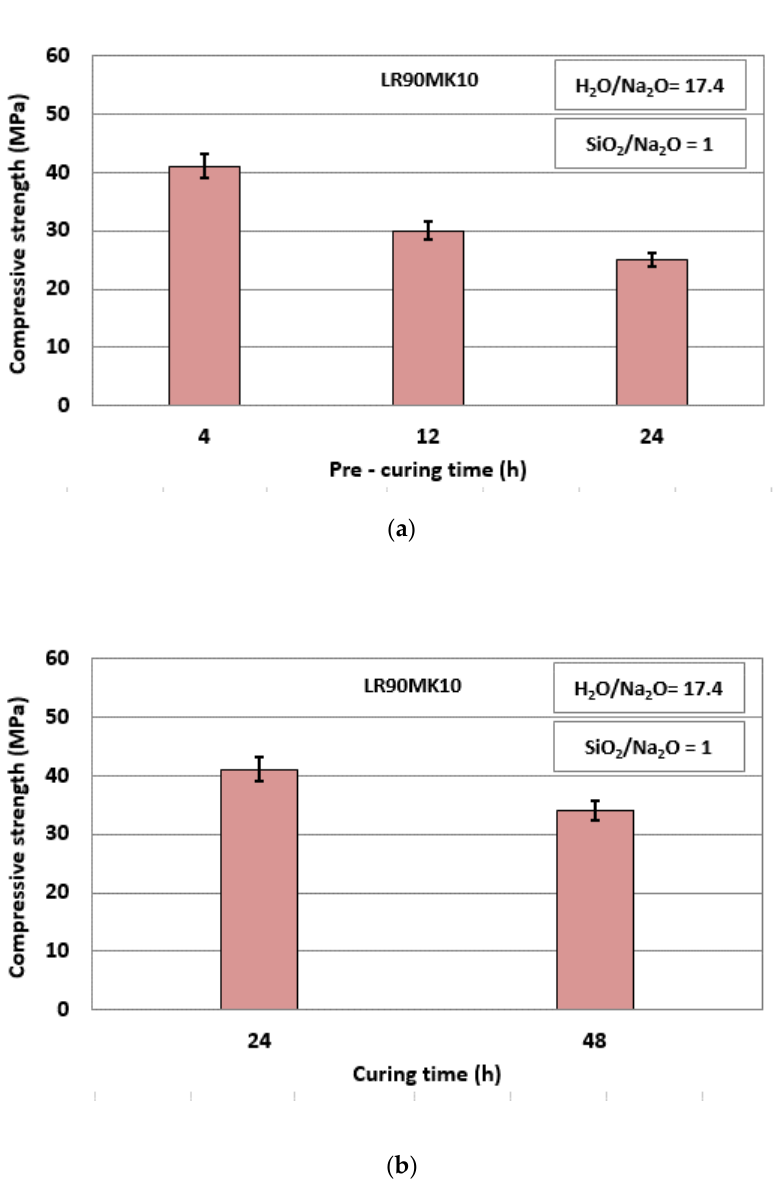
Figure 4. Effect of ( a ) pre-curing time and ( b ) curing time on the compressive strength of LR90MK10 AAM (curing temperature, 80 °C; ageing period, 7 days; error bars denote standard deviation of measurements obtained from three specimens).